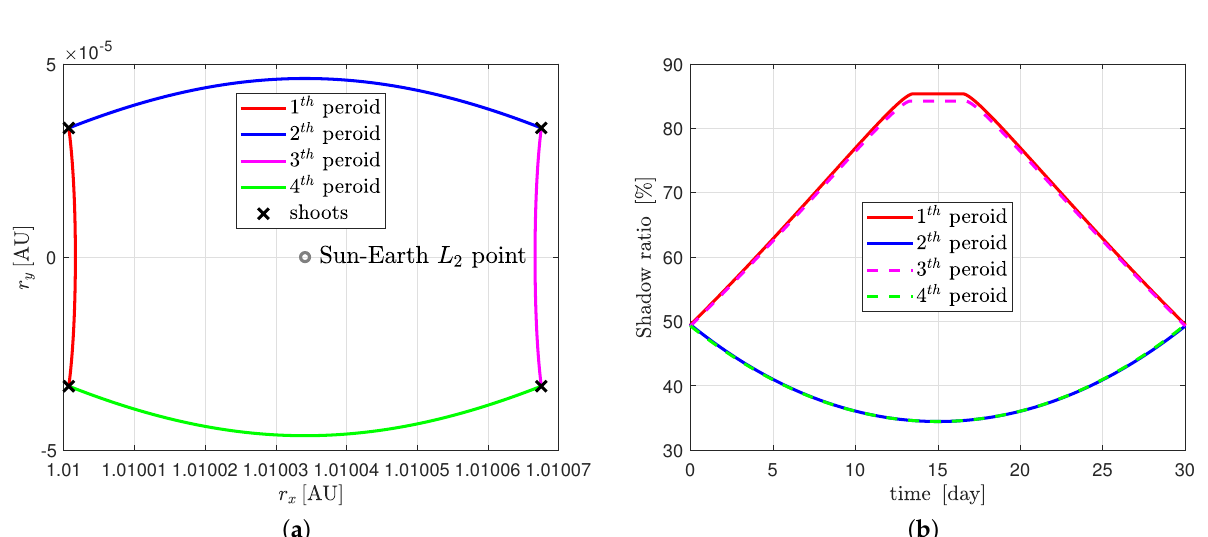
Figure 7. Nominal trajectory and its measurement parameters. ( a ) Nominal trajectory. ( b ) Measure- ment curve.